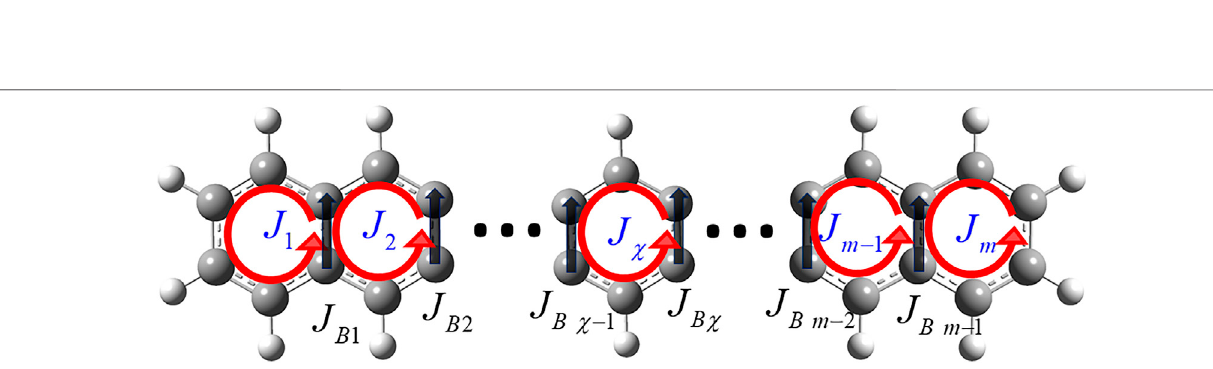
FIGURE 6 | π -Electron ring currents J l and bridge bond currents J Bl ′ (1 ≤ l ≤ m , 1 ≤ l ′ ≤ m − 1) in a linear planar polycyclic aromatic hydrocarbon (PAH). J χ refers to the π -electron ring current localized on aromatic ring χ .